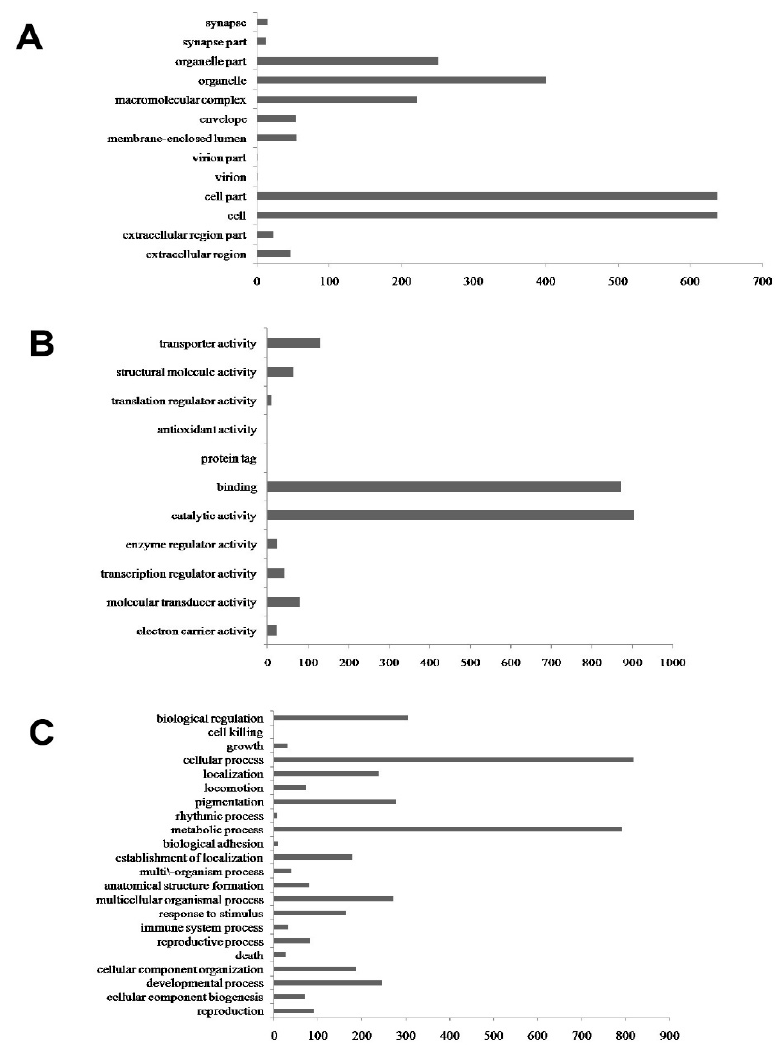
Figure 2. Functional categorization of DEGs between virus-treated and control M. persicae . The genes were categorized based on GO annotation using Blast2GO, and the number of DEGs in each category is shown on the x-axes. The three main ontology categories are Cellular Component ( A ), Molecular Function ( B ), and Biological Process ( C ).